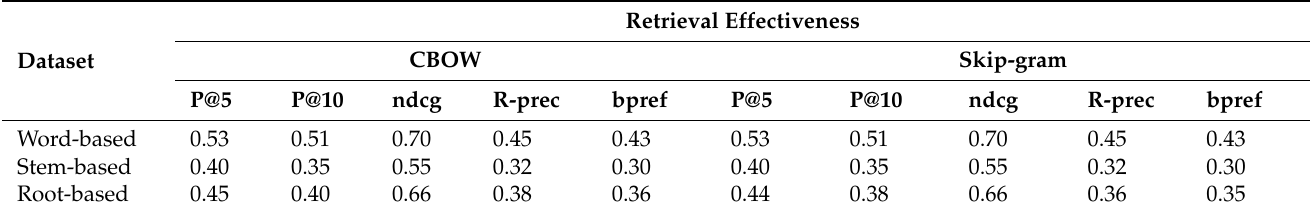
Table 7. Retrieval effectiveness of query expansion using word2vec.